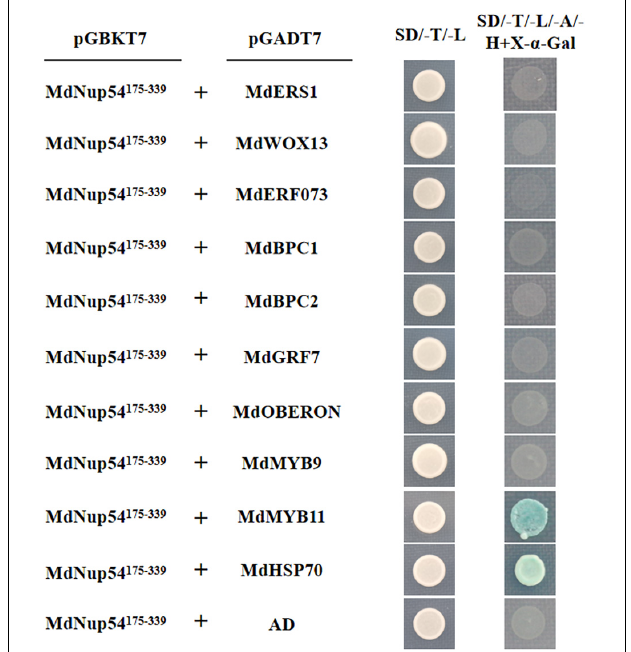
FIGURE 4 | Yeast two-hybrid validation of MdNup54 interacting proteins. The MdNup54 175 - 339 truncated sequence was cloned into pGBKT7, whereas others were cloned independently into the pGADT7 vector. Empty pGADT7 plus MdNup54 175 - 339 -pGBKT7 was used as the